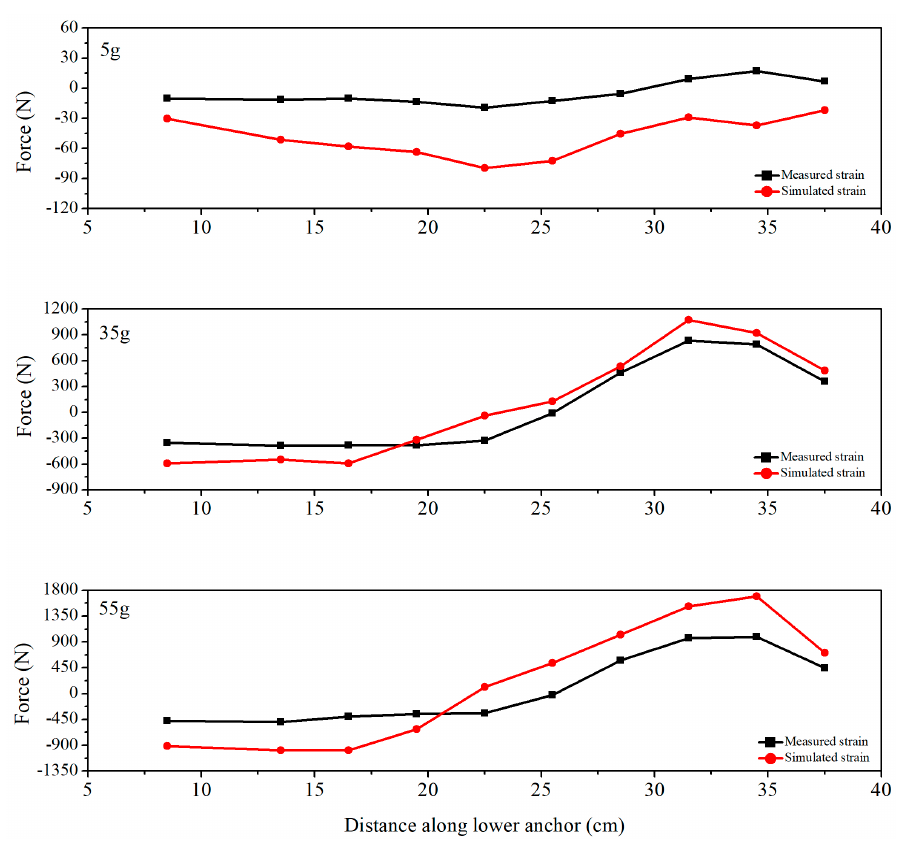
Figure 15. Comparison between the axial force provided by the FBG-based anchor and simulation.